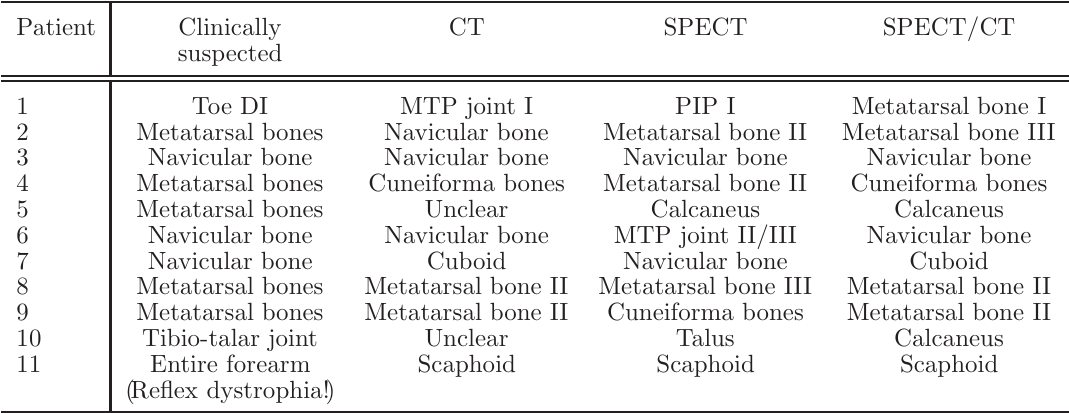
Table 1 Clinically suspected lesion localization, and CT and SPECT/CT lesion localiza-